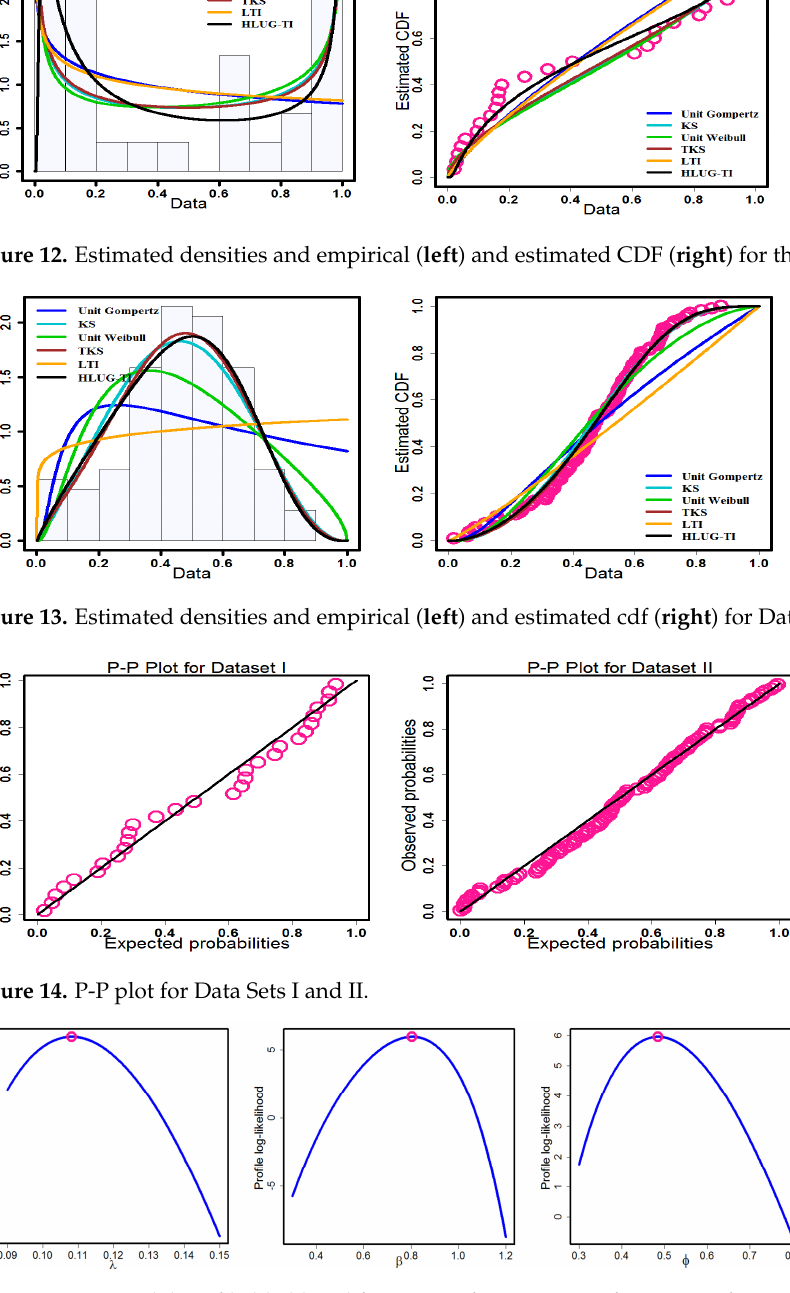
Figure 15. Unimodal profile likelihood functions of parameters of HLUG-TI for Data I.